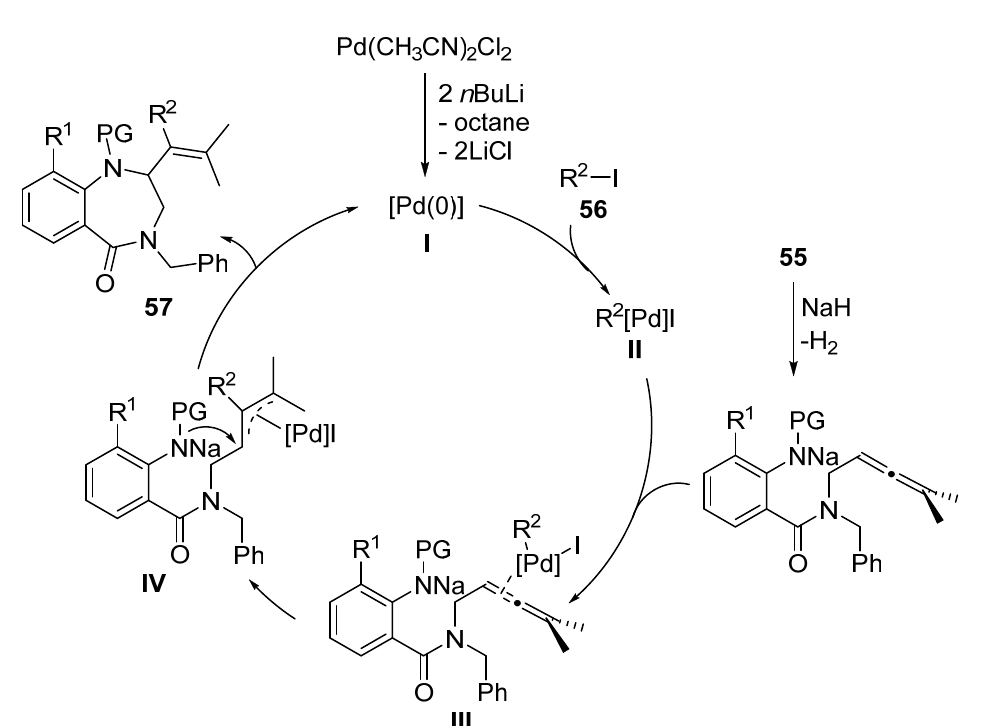
Scheme 27. Proposed mechanism for the synthesis of tetrahydrobenzodiazepinones 57 .